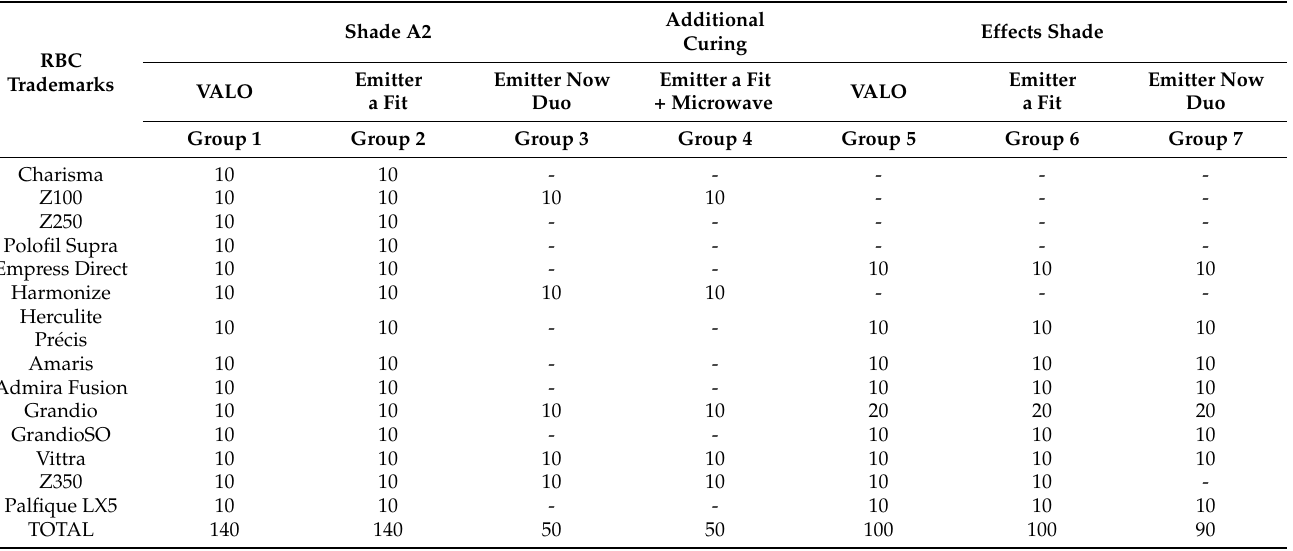
Table 2. Sample size (n = 10, following other studies [4,7,13]) according to the shade of RBC and the curing